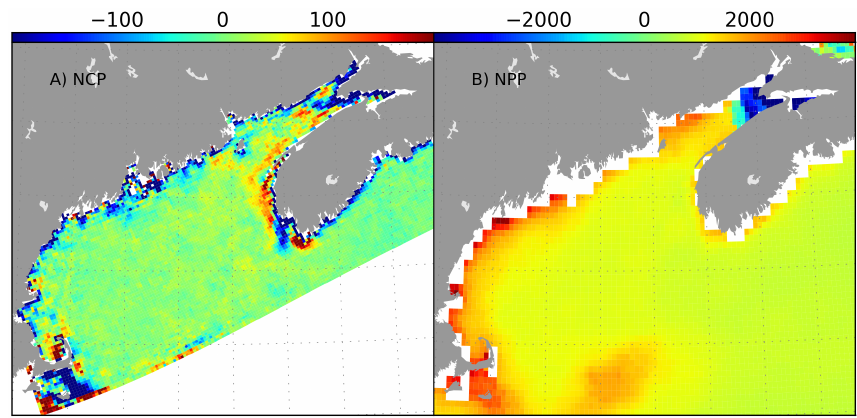
Fig. 6. Panel (A) shows the three year (2004–2006) median of NCP e for the Gulf of Maine, calculated using the method described in Sect. 2. Fig. 6. Panel A shows the three year (2004-2006) median of NCP e for the Gulf of Maine, calculated using Panel (B) shows Net Primary Production (NPP) calculated using the VGPM algorithm (Behrenfeld and Falkowski, 1997) for the equivalent the method described in section 2. Panel B shows Net Primary Production (NPP) calculated using the VGPM time